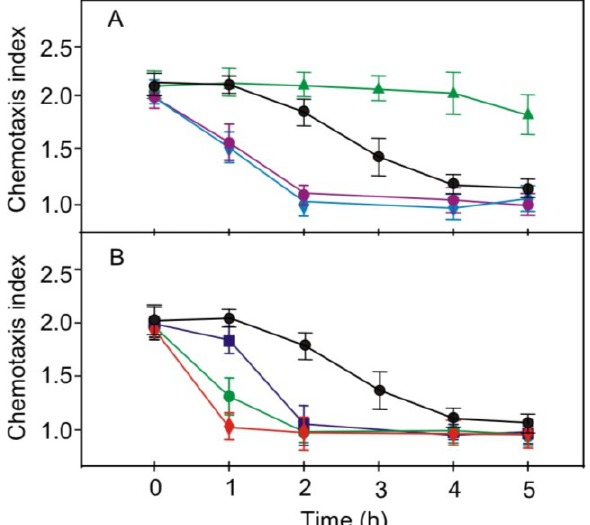
Figure 6. Effects of various pharmacological compounds on the light-induced loss of chemotaxis towards nitrate in pregametes of phototropin-reduced strain RNAi20. ( A ) Effect of staurosporine (♦), chelerythrine (●) or SC-9 (▲) on the loss of chemotaxis in pregametes of RNAi20 that were shifted into white light at time 0.; ( B ) Treatment with papaverine (●), IBMX (♦) or db-cAMP (■) on the loss of chemotaxis in pregametes of RNAi20 that were shifted into white light at time 0. Compounds were added to pregametes 10 min prior to start of illumination. The concentrations used were 1 μM for